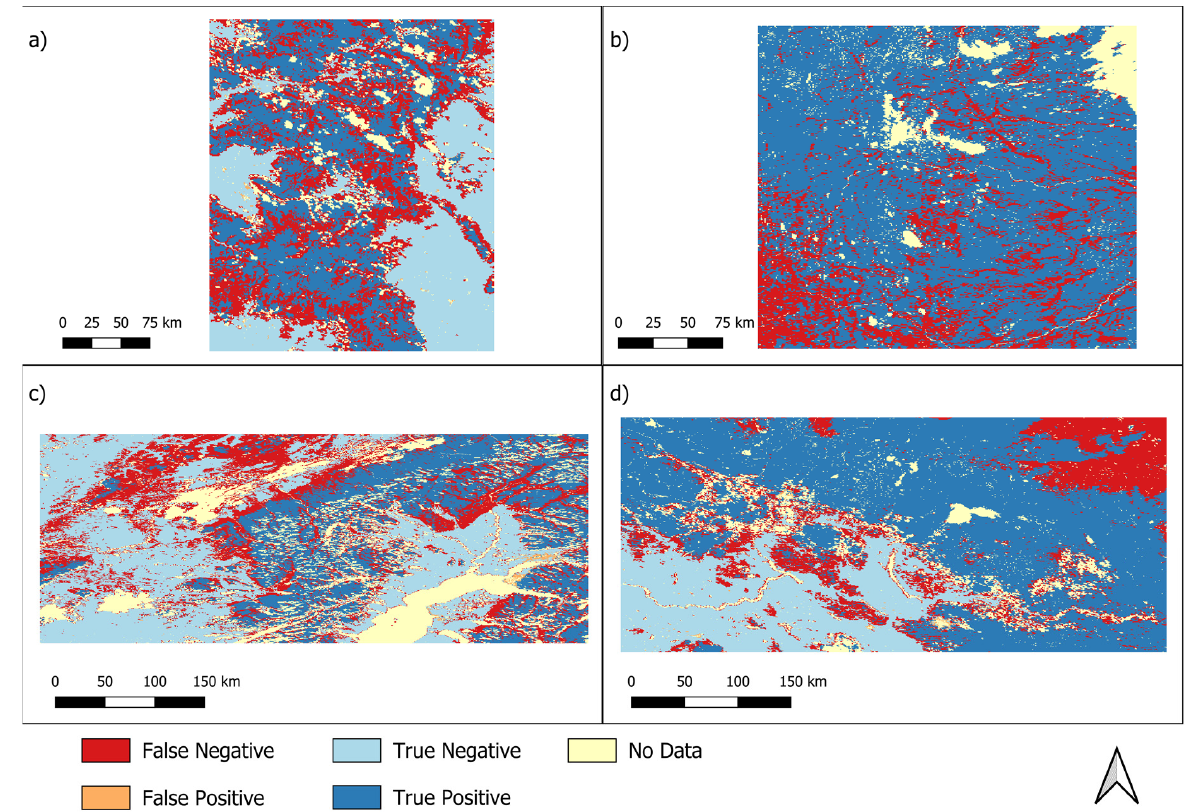
Figure 2. Maps of the confusion matrices: ( a ) Colorado—mean thresholding; ( b ) Ontario—Yen thresholding; ( c ) Alaska—mean thresholding; (d ) Saskatchewan—Li thresholding.